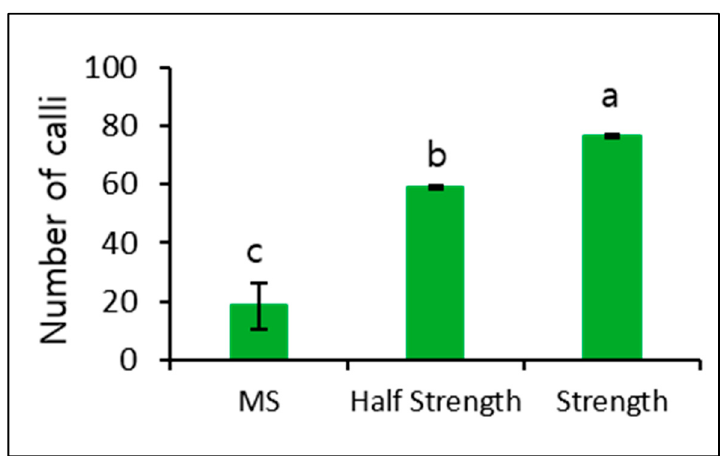
Figure 5. Effect of different culture media on callus formation from microcalli in the dark. Data represent the means of three replications. The bar indicates the standard deviation of three replications. Means with the same letters are not significantly different by the least significant difference test ( p < 0.05).